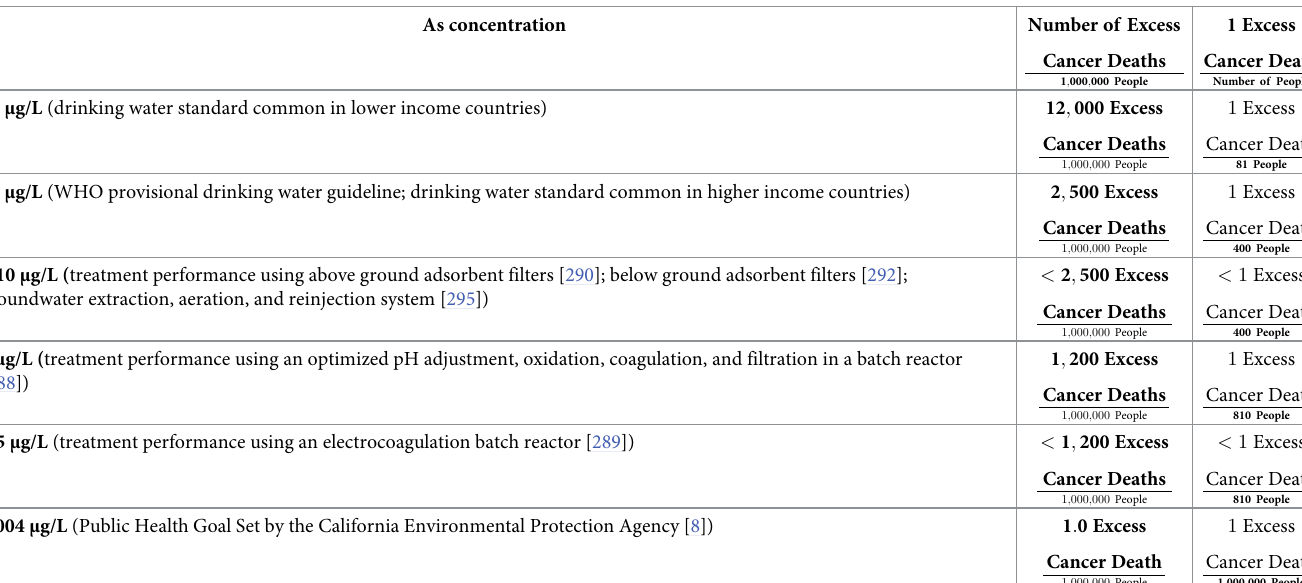
Table 3. Common drinking water standards, guidelines, and public health goals for total arsenic (As) in micrograms per liter ( μ g/L), the effluent concentrations of total As in μ g/L from water treatment systems used in the low-income world, and the estimated cancer risks at these concentrations (Eqs 1, 2, 3, 4, 5 and 6). These cancer risks are in bold font and rounded to 2